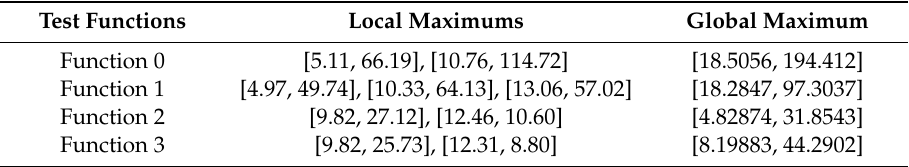
Table 2. Maximum points of the test functions.